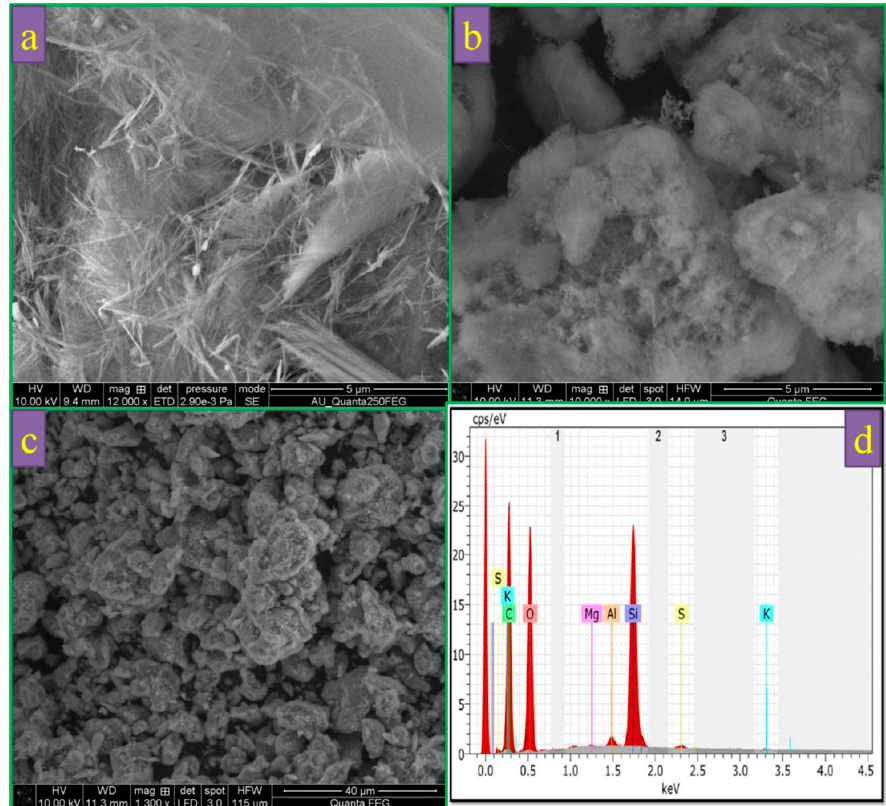
Figure 4. ( a ) sieved sepiolite,( b ) sublimed sulfur/ sieved sepiolite/PAni and ( c , d ) sublimed sulfur /post ‐ treated sepiolite/PAni,( e ) EDX analysis of composite material (sublimed sulfur /post ‐ treated / PAni). Polymers 2019 , 11 , x FOR PEER REVIEW sepiolite/PAni). sepiolite